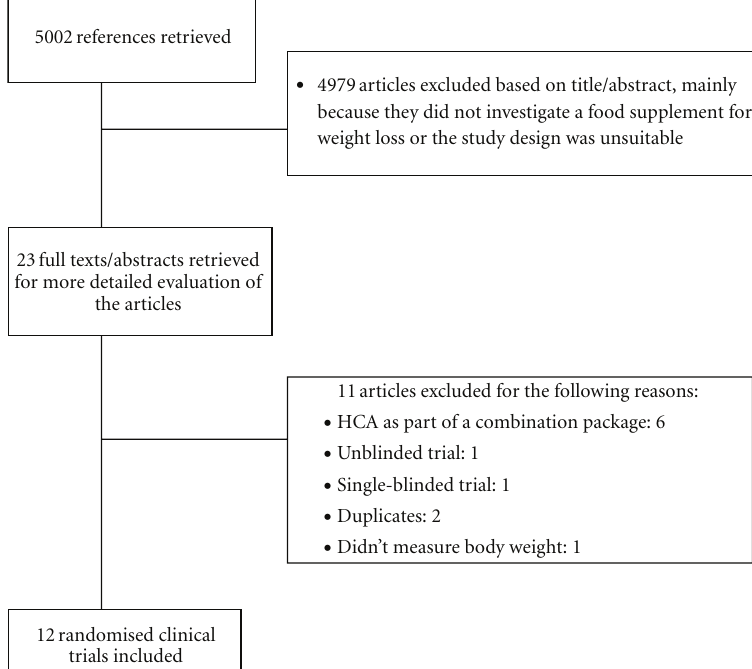
Figure 1: Flow chart showing the process for the inclusion of randomised controlled